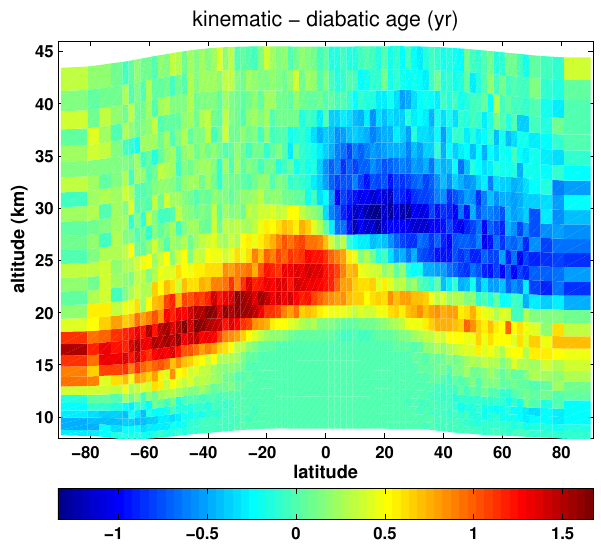
Fig. 3. Difference between mean kinematic age and mean diabatic age over 31 months in the period 2006-2009 (in yr). In order to understand better the relation between air parcel origins and ages, Fig. 4 shows the distributions of maximum vertical excursion and of altitude of tropopause crossing. The distributions are shown separately for parti- cles launched below 113 hPa in the extra-tropical lowermost stratosphere (lower row) and those launched at this level and above in the tropics and the extra-tropics (upper row), in the region of the stratosphere denoted as the overworld (Holton et al.,